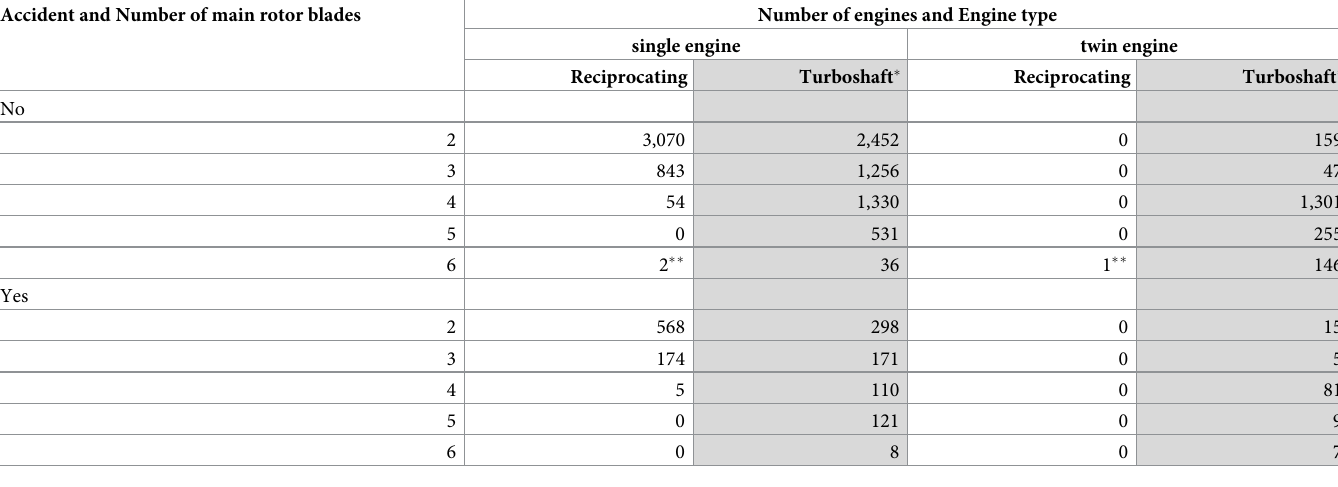
Table 1. Four-level frequency summary of civil helicopter dataset in the U.S. from 2005 to 2015. Accident and Number of main rotor